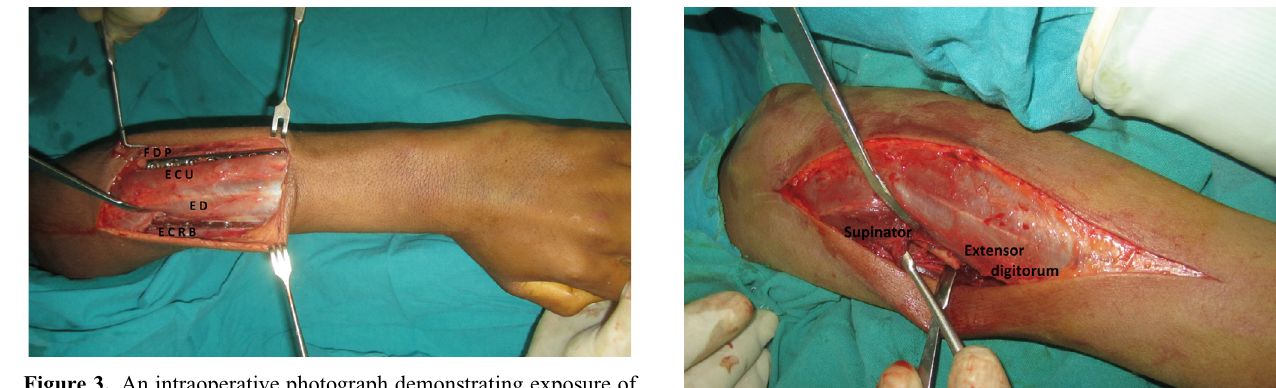
Figure 3. An intraoperative photograph demonstrating exposure of the radius between the extensor digitorum muscle (ED) and the extensor carpi radialis brevis muscle (ECRB), and the ulna between the extensor carpi ulnaris muscle (ECU) and the flexor digitorum profundus muscle (FDP) and fixation of each bone by a plate and screws.